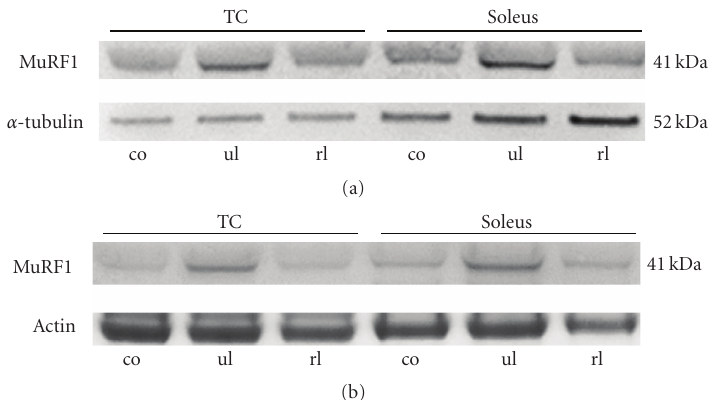
Figure 1: MuRF1 protein expression and hindlimb suspension. MuRF1 protein expression was monitored in tibialis cranialis (TC) and soleus (Sol.) muscles before (co; control), after unloading by hindlimb suspension (ul), and after reloading (rl). MuRF1 expression was compared relative to alpha-tubulin (a) or actin (b) as a control for loading and blotting. Low levels of MuRF1 protein were detected in control TC and Sol.; MuRF1 was severalfold elevated after unloading by hindlimb suspension in both muscle types and returned to nearly normal expression levels after 5 days of reloading (rl).